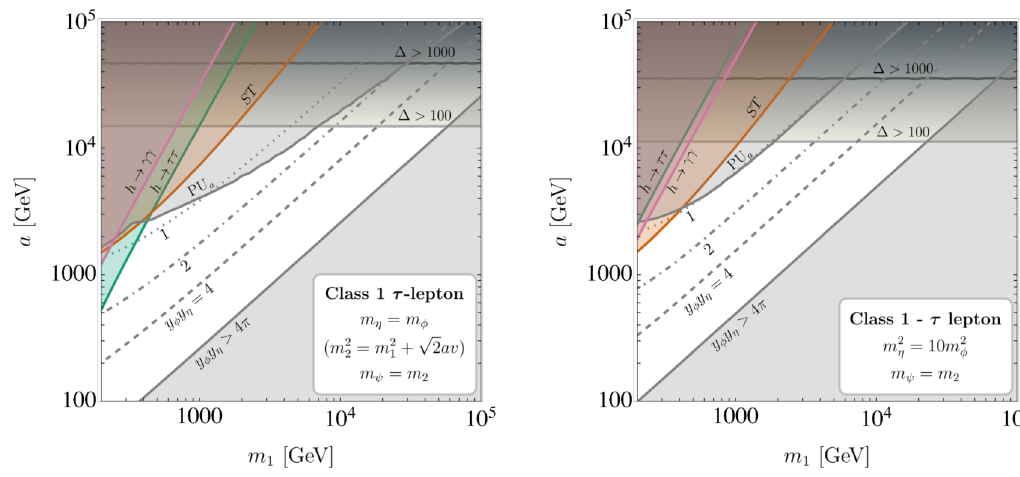
Figure 3. Theoretical (grey) and current 2 σ experimental constraints (coloured) on the Class 1 τ -lepton benchmark model. The product of Yukawas required to reproduce the observed tau mass is shown by contours at y φ y η ∈ { 1 , 2 , 4 } and the region which violates perturbative unitarity is shown in grey. The region where perturbative unitarity of the trilinear coupling is violated is shown in grey, and is indicated by PU a . The degree of fine-tuning is shown by contours at ∆ ∈ { 100 , 1000 } using the measure defined in appendix D. The coloured regions are experimentally excluded at 2 σ . ST represents the exclusion due to the S and T parameters, while h → ττ and h → γγ give the exclusion due to the indicated signal strength.